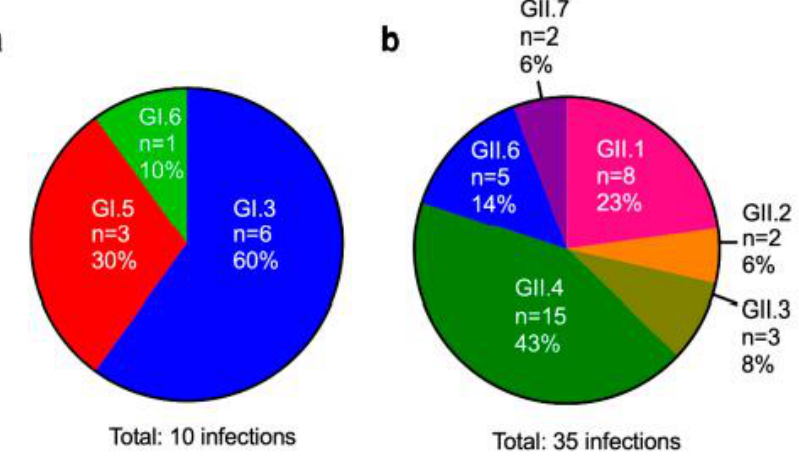
Figure 2. Co-circulating human norovirus strains in immunocompromised patients at a pediatric research hospital. Three GI genotypes ( a ) and 6 GII genotypes ( b ) were detected with varying frequencies.